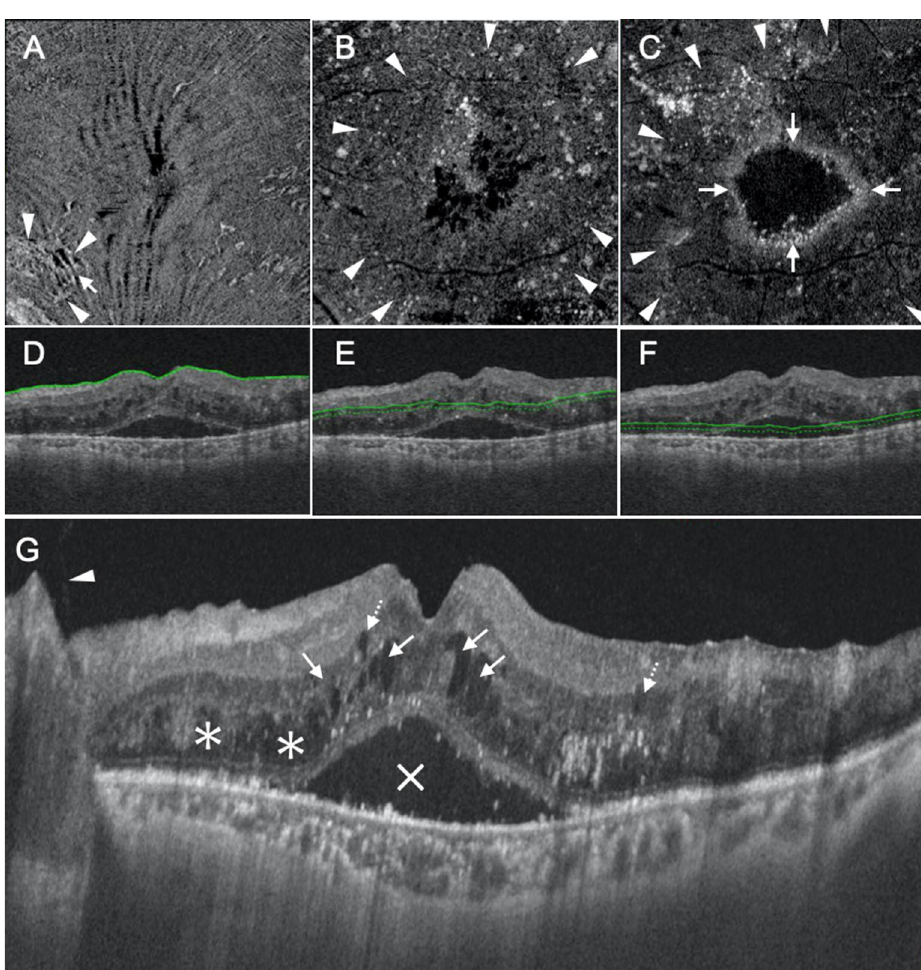
Figure 5. Representative case showing the diffuse fluid at Segment 1/diffuse fluid with subretinal fluid at Segment 2 type of diabetic macular edema. ( A – C ) En face images of the retinal surface ( A ), Segment 1 ( B ), and Segment 2 ( C ) are presented. Epiretinal membrane (arrowheads in A ) and associated retinal folds (arrows in A ) can be observed at the surface of the retina. There is diffuse fluid with an area larger than the parafoveal area at both Segments 1 and 2 (arrowheads in B , C ). Subretinal fluid, visualized as a high-intensity ring-shaped region, can also be observed at Segment 2 (arrows in C ). ( D – F ) B-scan images and the green lines show the locations at which the en face images of the retinal surface ( D ), Segment 1 ( E ), and Segment 2 ( F ) were generated. The scan depth, indicated by the distance between the green line and green dotted line, was set to 0 μm for the en face image of the retinal surface ( D ) and 50 μm for the en face images of both Segments 1 and 2 ( E , F , respectively). ( G ) A horizontal B-scan image centered at the fovea is presented. The fluid at Segment 1 is located at both Henle’s fiber layer (arrows in G ) and the inner nuclear layer (dotted arrows in G ). There is diffuse fluid at Segment 2 (asterisks in G ). The X in ( G ) indicates subretinal fluid and the arrowhead in ( G ) shows that the posterior hyaloid is detached from the retina completely but remains attached to the optic